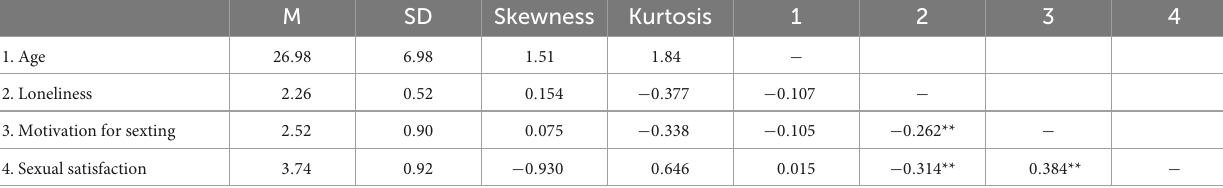
TABLE 1 Means, standard deviation and correlations between loneliness, motivation for sexting and sexual satisfaction. M SD